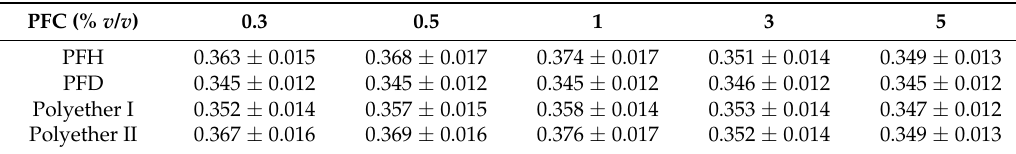
Table 2. Specific cell growth rate (μ, h −1 ) for E. coli SG13009[pREP4] for various concentrations of PFCs in the culture medium *.